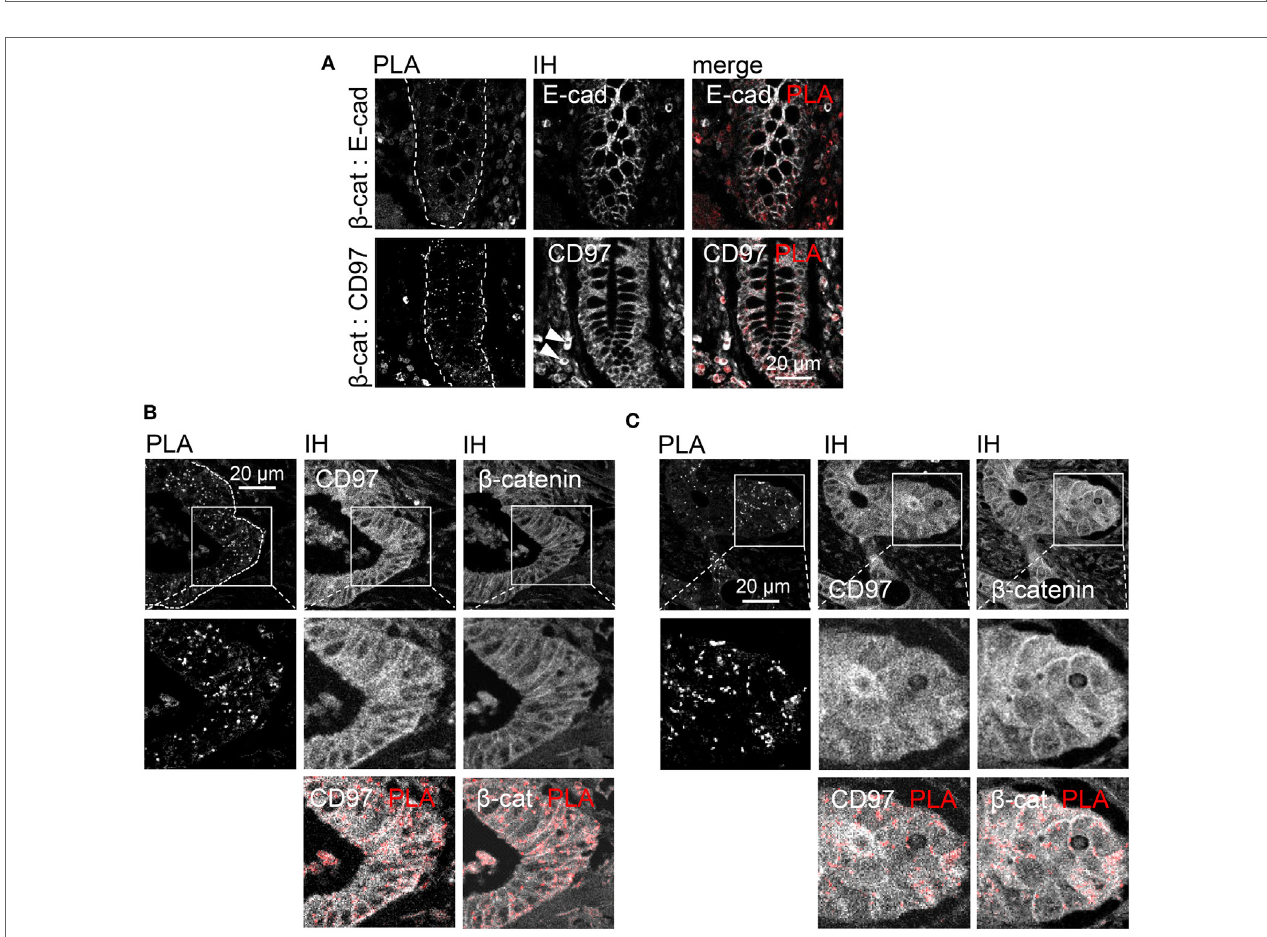
FigUre 5 | Restriction of CD97: β -catenin interaction to cellular junctions in normal colon and colorectal carcinomas. (a) Normal colon. Upper panel: E-cadherin: β -catenin interaction (positive control) was detected in lateral enterocytic cell contacts. Lower panel: CD97 was present in lateral and basolateral contacts of enterocytes and in leukocytes (arrow heads). CD97: β -catenin interaction was restricted to lateral junctions. (B) In this part of a colorectal carcinoma, mainly membranous CD97 and β -catenin expression was evident. CD97: β -catenin proximity ligation assay (PLA) interaction spots located only at the junctions. (c) Although CD97 and β -catenin were both expressed at high levels in the cytoplasm of this tumor, the interaction was restricted to the lateral cell contacts as seen in the PLA/immunohistology merged picture. Interaction spots are arranged as pearls at a string in the lateral contacts of tumor cells.